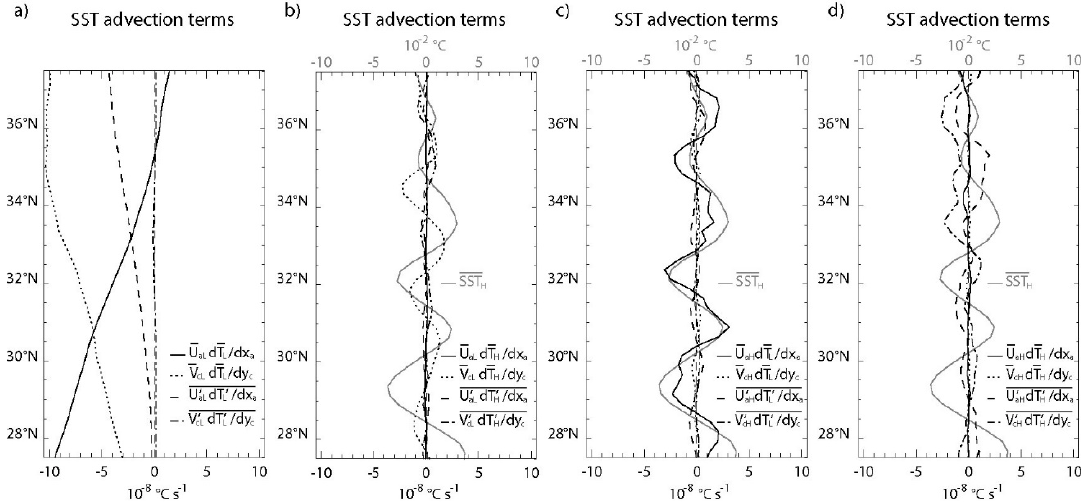
Figure 8. Cross-striation profiles (off the coast of California) of the SST advection terms (as listed in equation (10)), averaged quasi-zonally within the tilted solid box on Figure 7a,b. Each panel displays four terms (mean and eddy along-striation and cross-striation components) accounting for: ( a ) the advection of large-scale SST by the large-scale flow; ( b ) the advection of mesoscale SST by the large-scale flow; ( c ) the advection of large-scale SST by the mesoscale currents; and ( d ) the advection of mesoscale SST by the mesoscale currents. The profile of mean spatially high-pass filtered SST is also shown in panels ( b – d ).